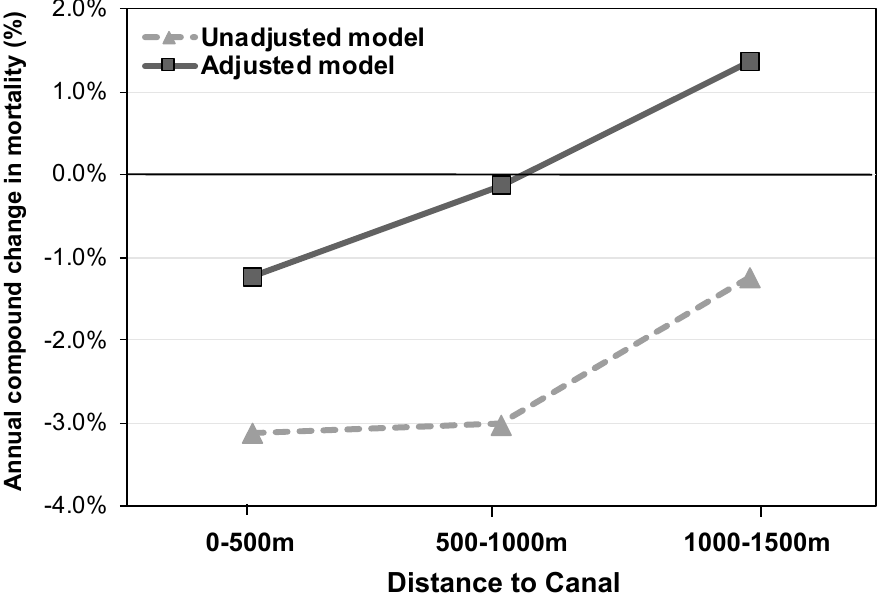
Figure 5. Annual compound change in mortality rate for three buffer zones (distance between 2001 data zone centroids and nearest portion of the canals), estimated from linear mixed models with and without adjustment for Scottish Multiple Deprivation Score (SIMD) decile scores for the domains income, housing, employment, education, and geographical access.